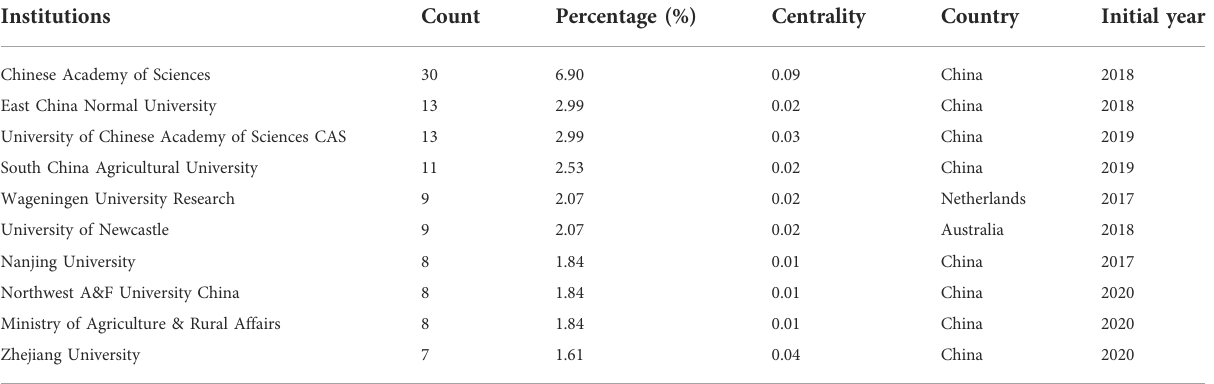
TABLE 2 Top ten most productive institutions in terms of relevant